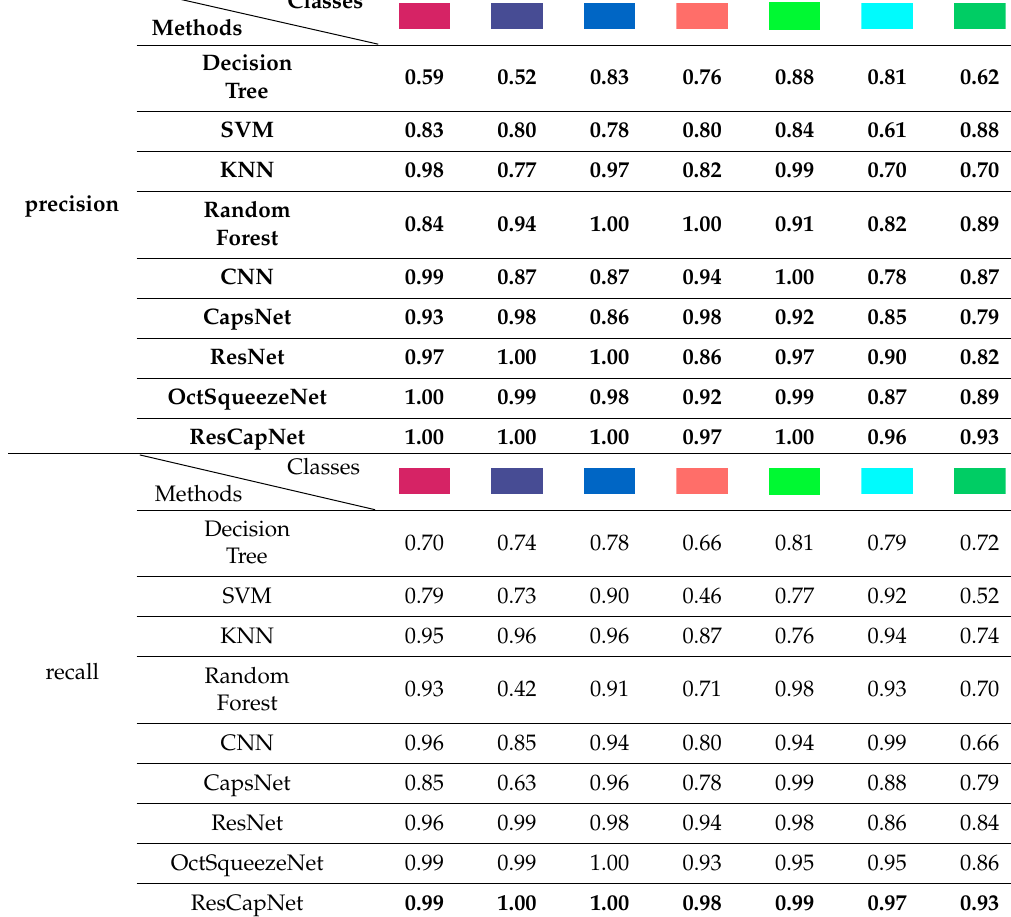
Table 5. Precision and recall of each class for 700 samples on Recology data set.